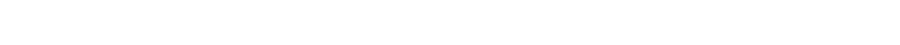
Frontiers in Energy Research | Energy